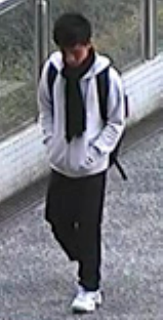
Figure 2. An example of a pedestrian image and labels in the PETA dataset.